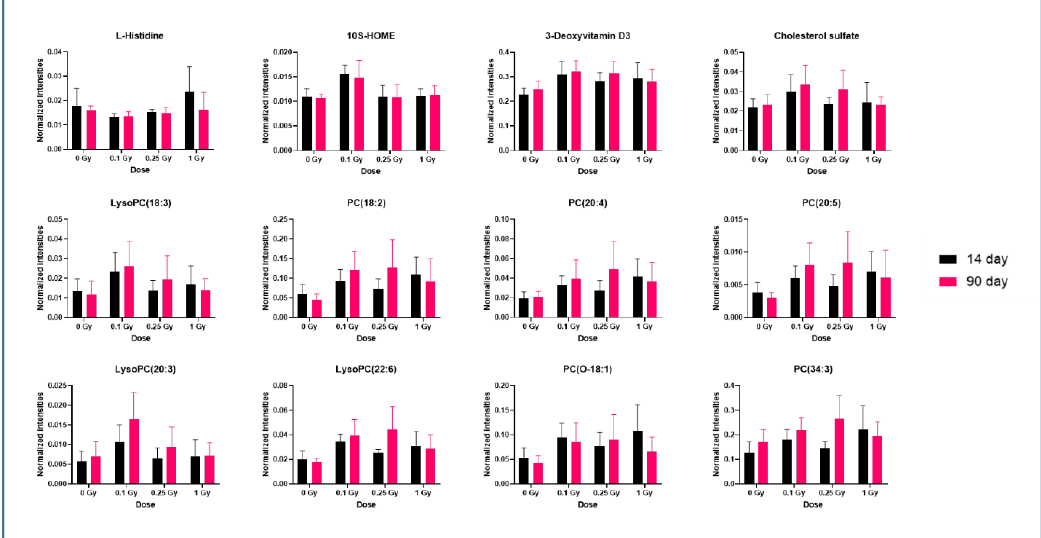
Figure 4. Exposure to low dose high-LET radiation causes dyslipidemia. Box plots for relative response of representative metabolites in mice exposed to sham, 0.1 Gy, 0.25 Gy or 1 Gy of 16 O radiation at days 14 and 90 post-irradiation.